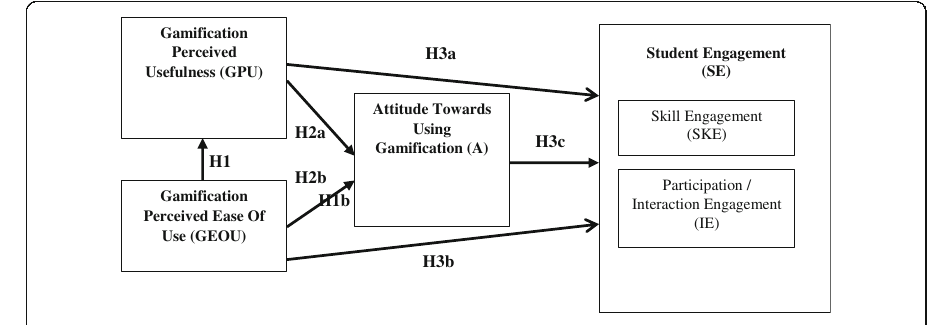
Fig. 2 Proposed research model - Gamification Acceptance Model